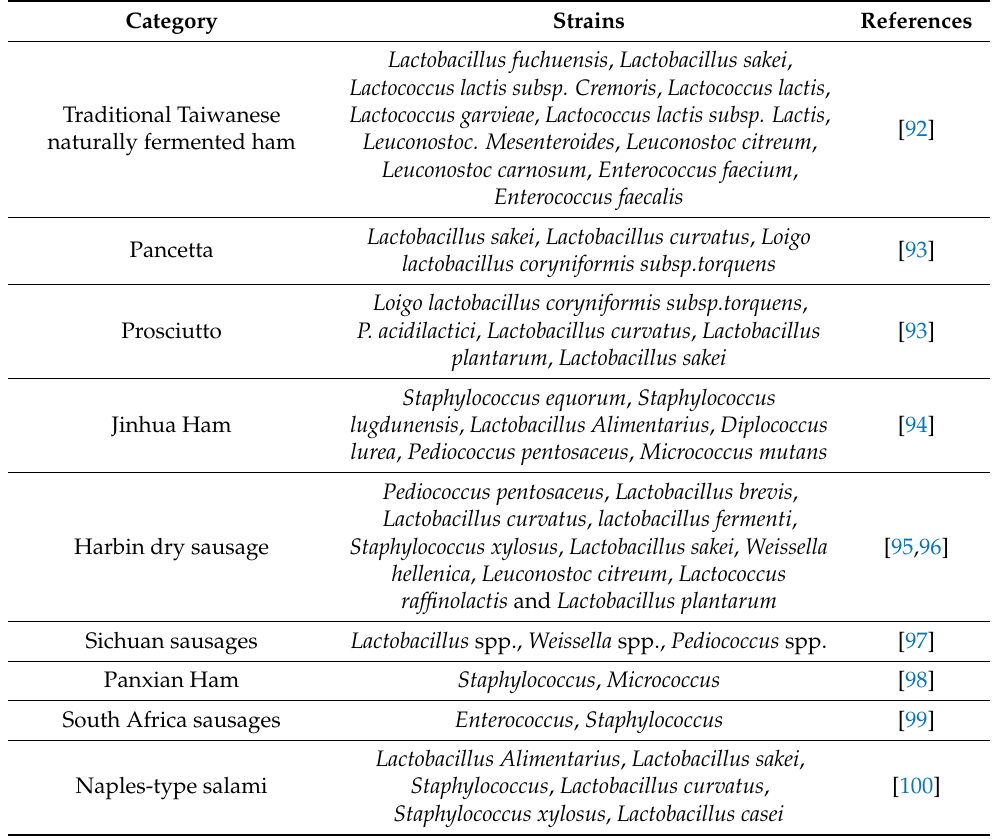
Table 2. LAB from different fermented meat products at different